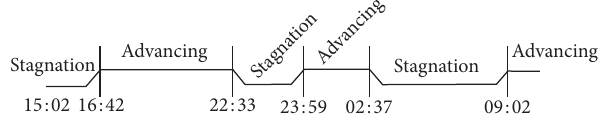
Figure 18: Measuring period.